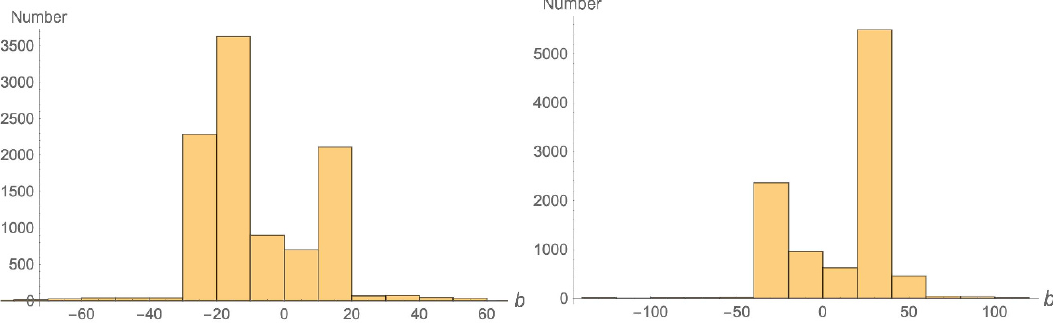
Figure 11 . The distribution of b for generation 10 (left) and 30 (right).